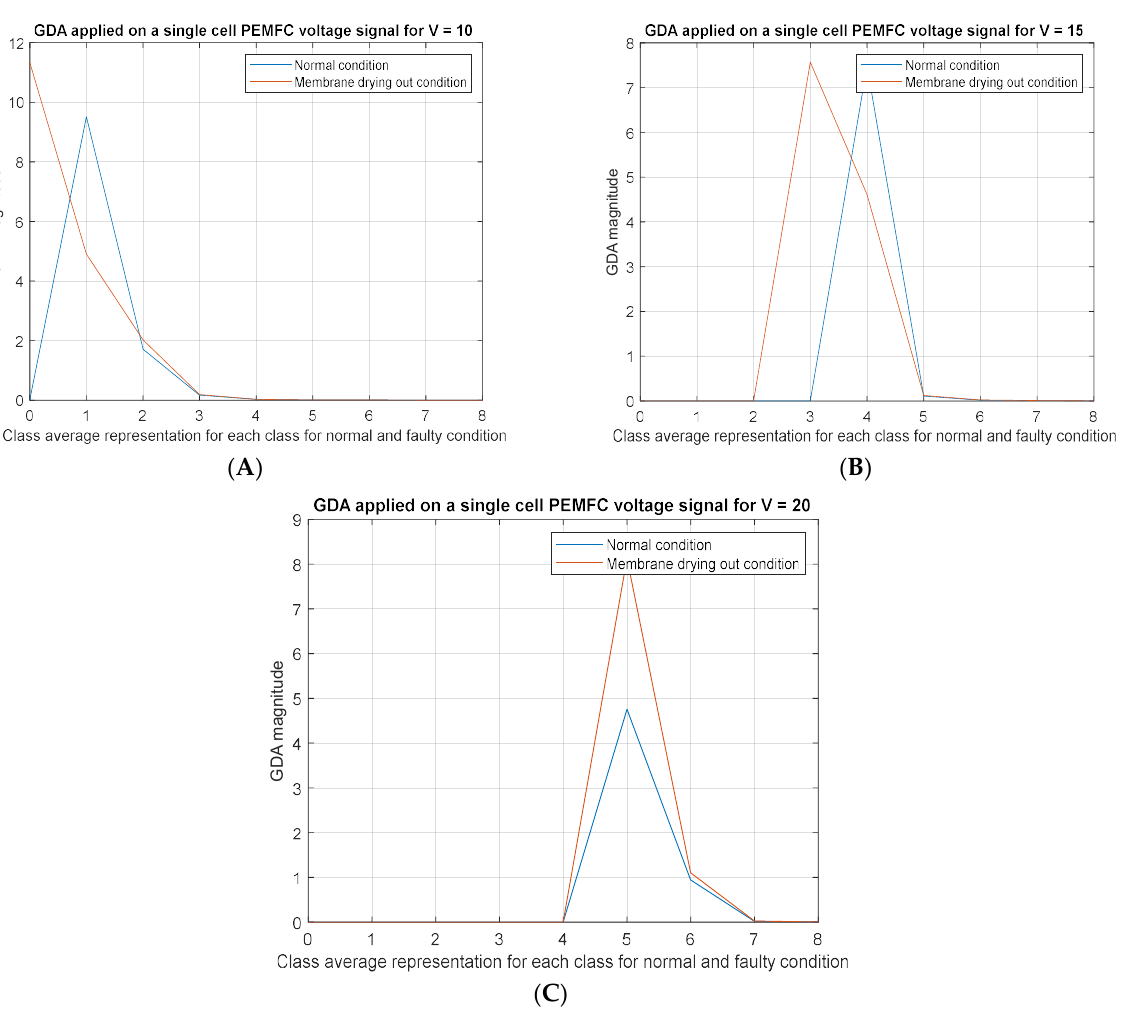
Figure 17. Classes representation for V = 10 (A), V = 15 (B) and V = 20 (C).